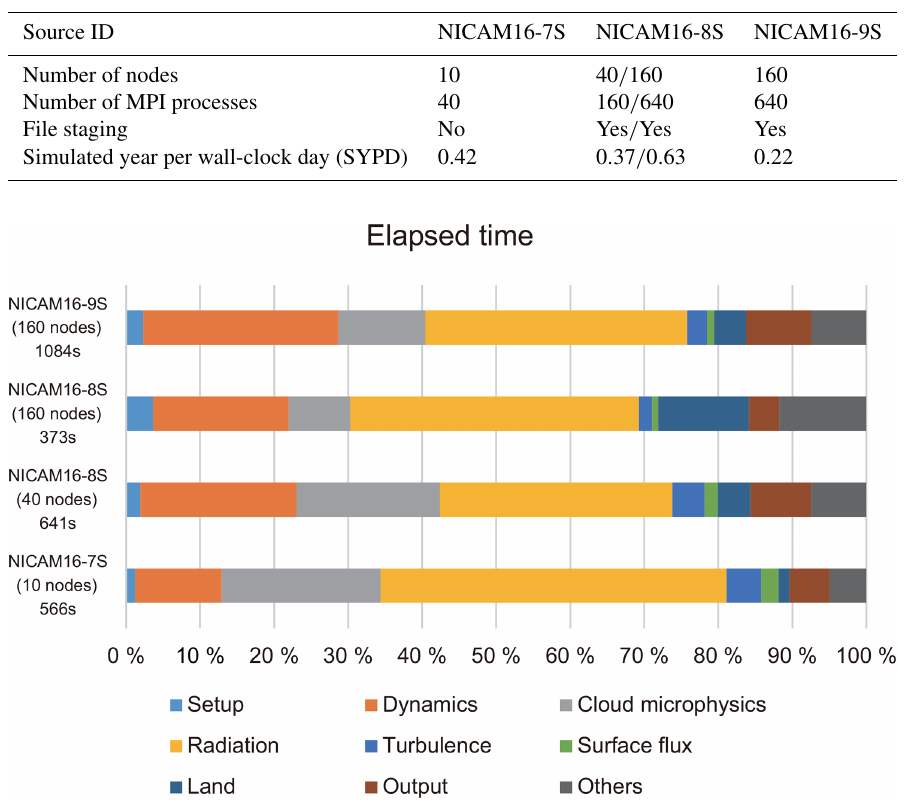
Table 7. Computational aspects of the simulations on the Earth Simulator 3. They are sampled from 6-month simulations (1 July 2004–31 December 2004).